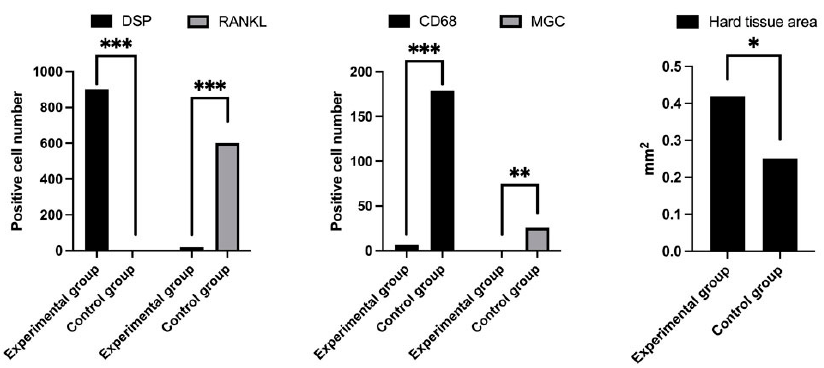
Figure 4. Quantification of the number of IHC-positive cells, number of MGCs, and hard tissue area in the tissue specimens. *** p < 0.0001, ** p < 0.001, * p < 0.05.